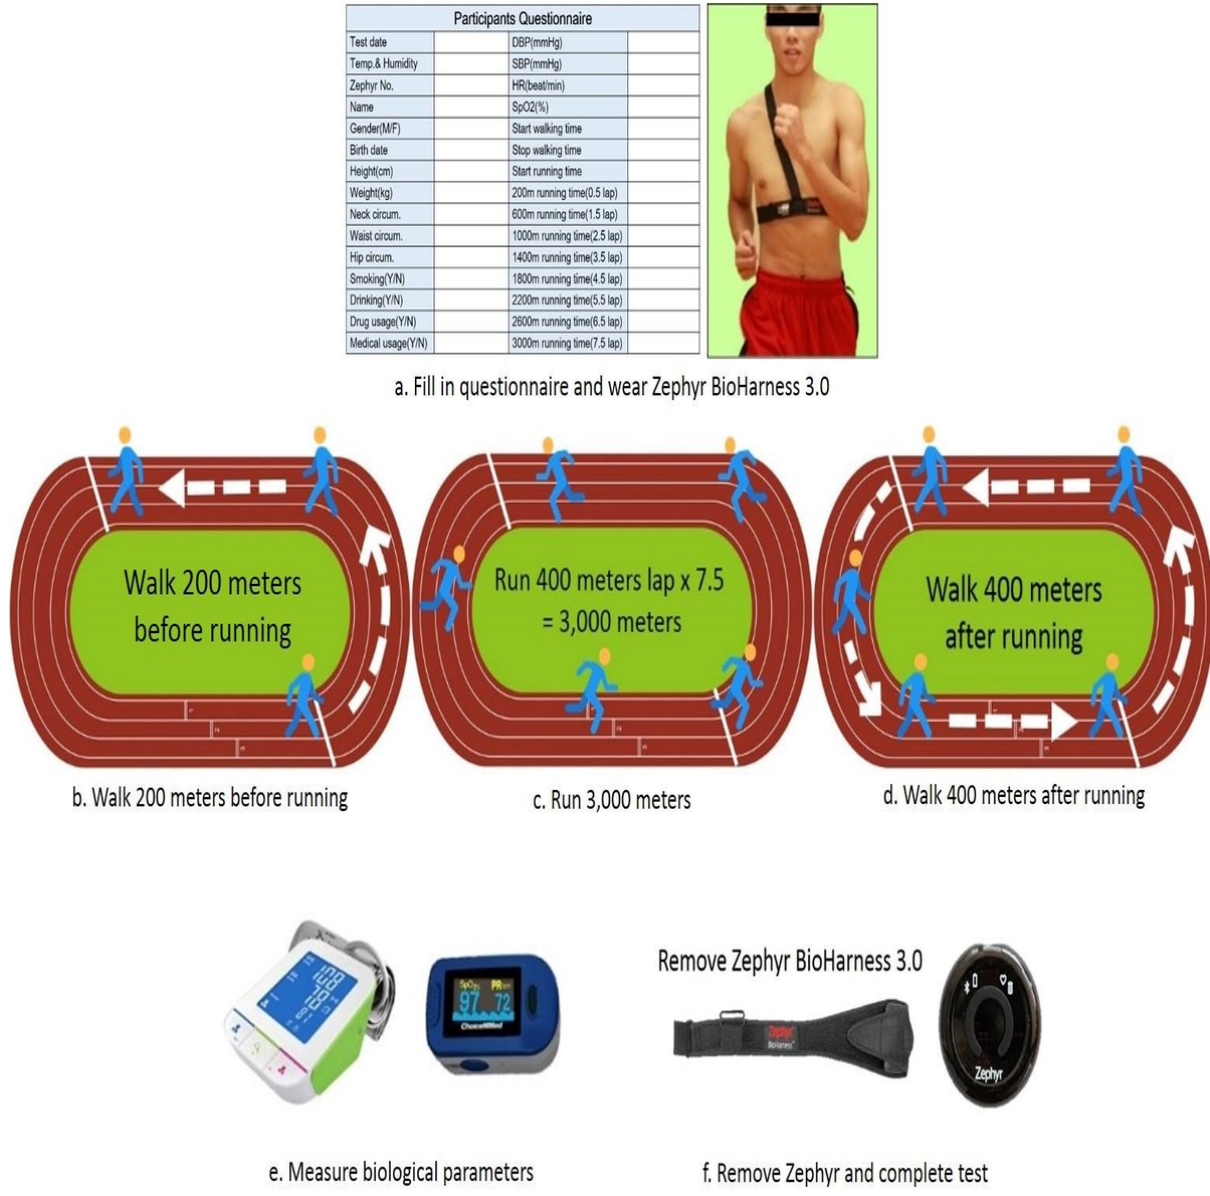
Figure 1. The process of collecting data followed six steps in this